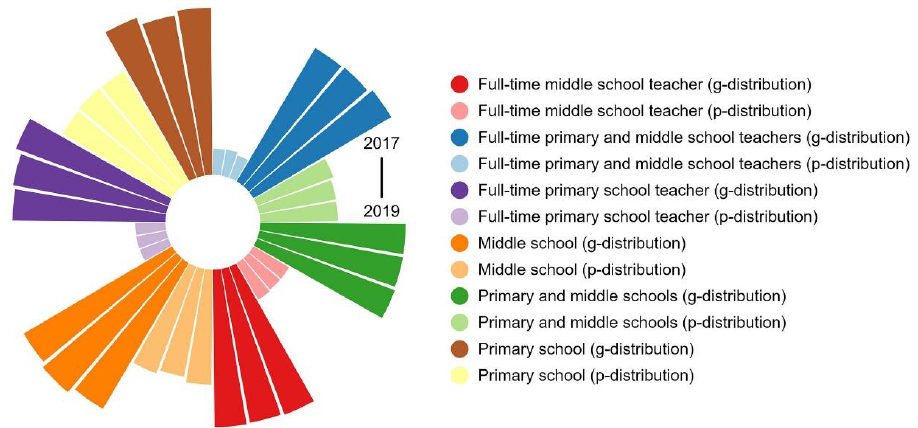
Figure 10. ID from 2017 to 2019. p-distribution represents population distribution; g-distribution represents geographic distribution; time increases in the clockwise direction.